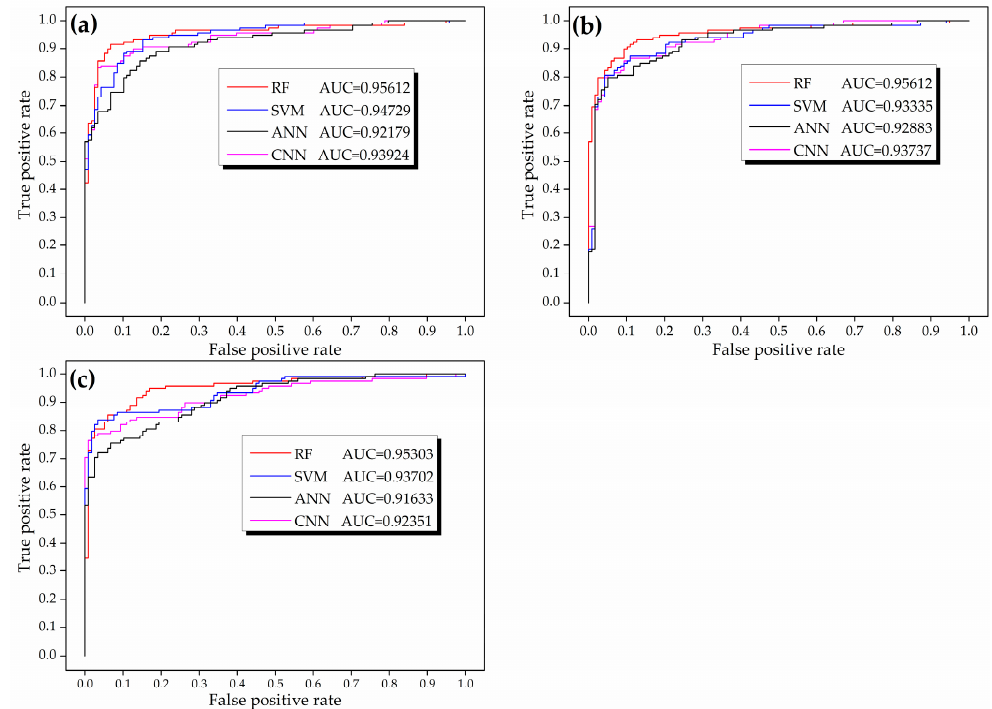
Figure 11. ROC curves and AUCs of ML models trained by Dataset 1 ( a ), Dataset 2 ( b ), and Dataset 3 ( c ).